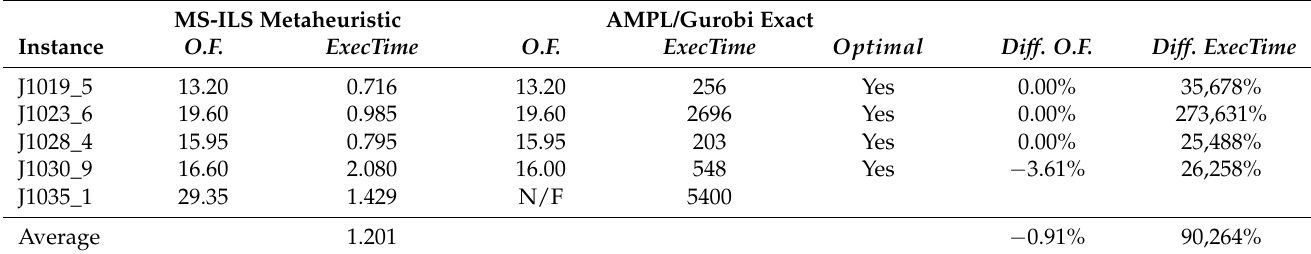
Table 9. Experiment 3 results. Performance test using instances with 10 activities.